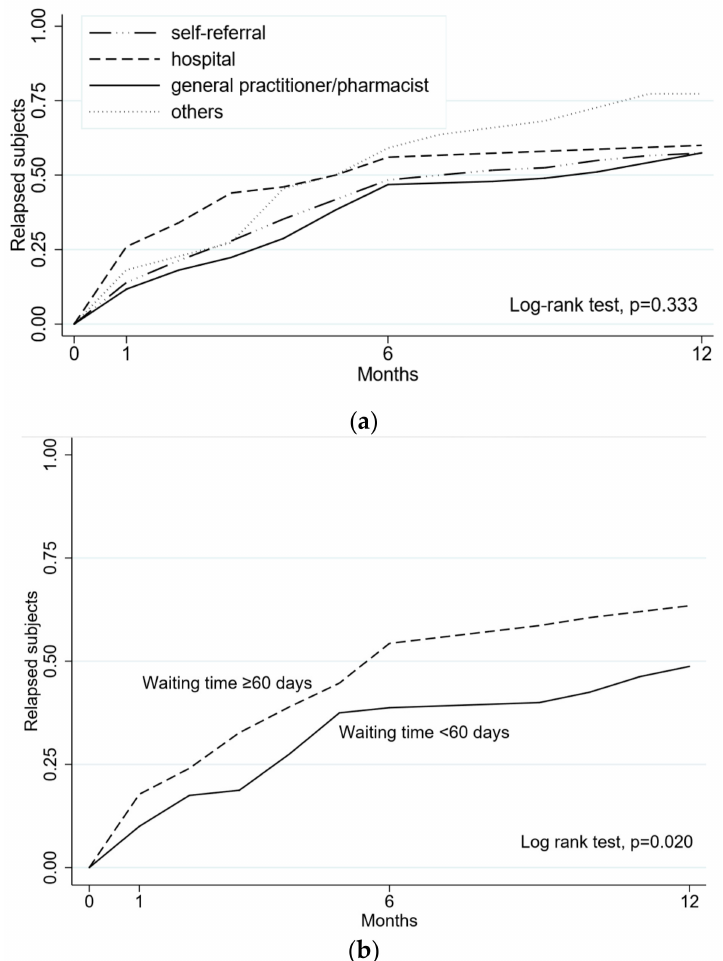
Figure 3. ( a ) Kaplan–Meier estimates of treatment failure at 12 months at the smoking cessation service of Reggio Emilia, according to the referral source. ( b ) Kaplan–Meier estimates of treatment failure at